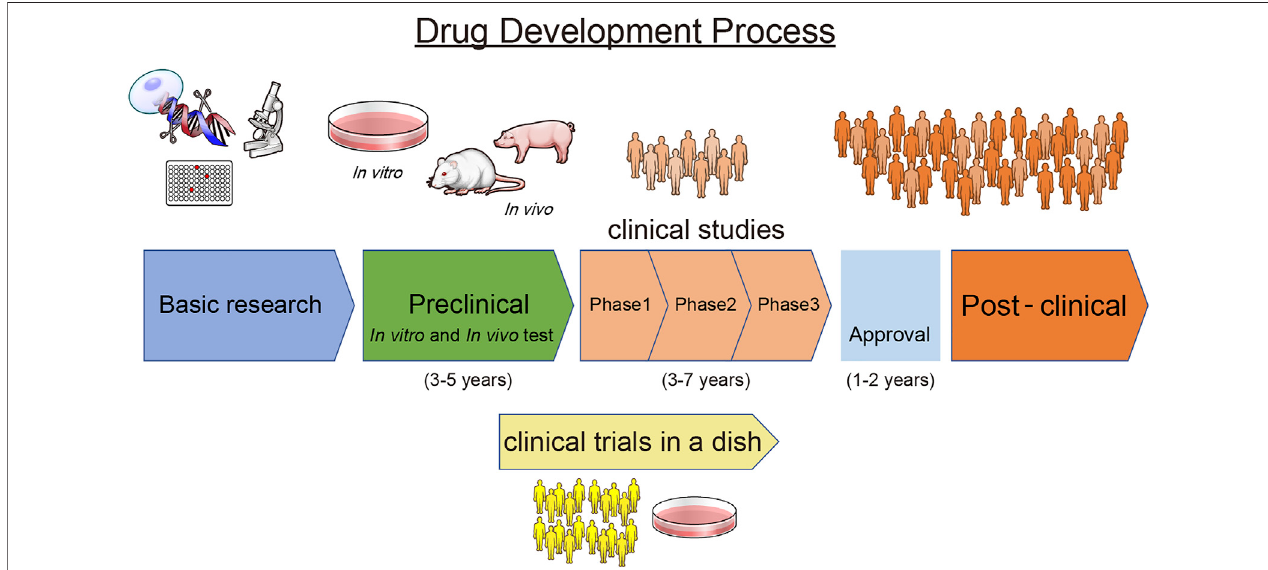
FIGURE 3 | Drug Development Process. A scheme describing the drug development process.